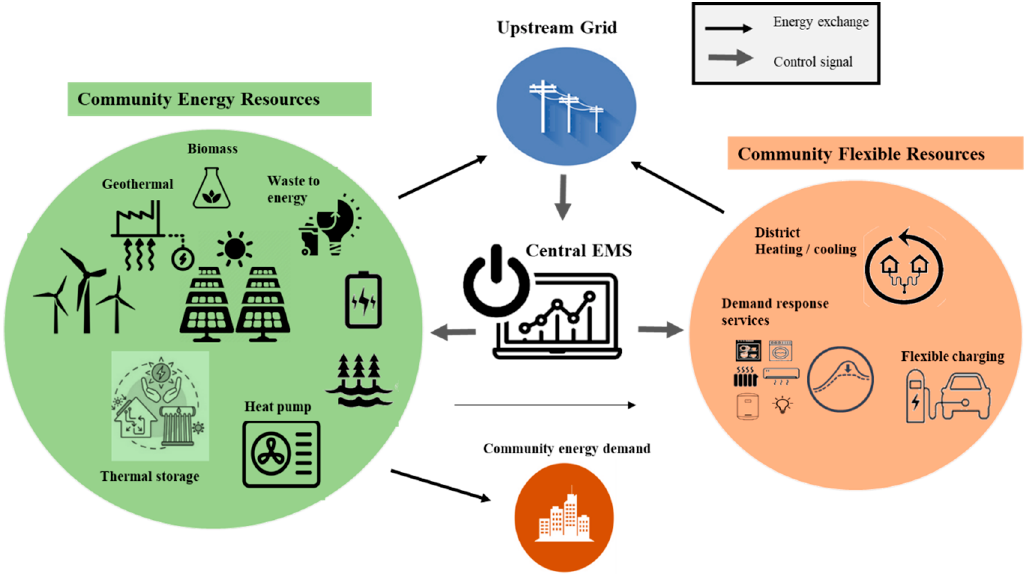
Figure 10. Energy community management.